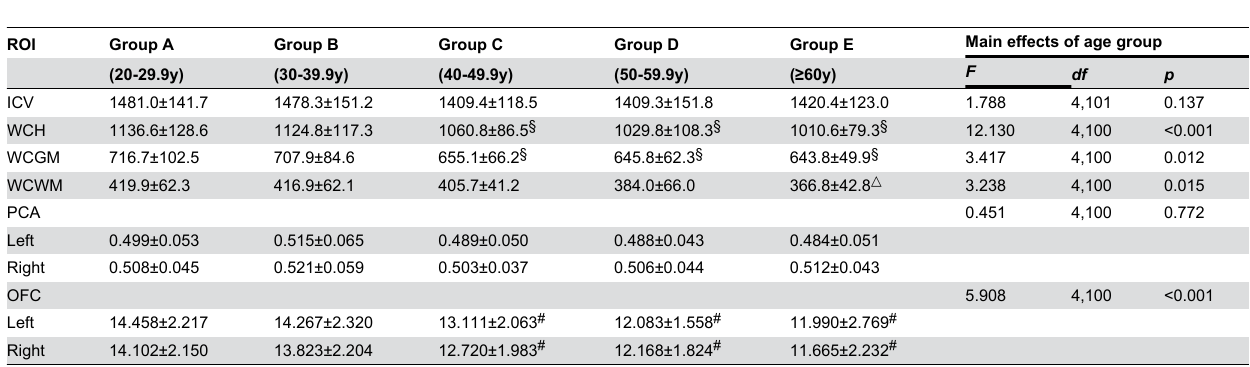
Table 1. Volumes of the intracranial cavity, cerebral hemisphere, cerebral gray and white matter, piriform and cortical amygdala (PCA) and orbitofrontal cortex (OFC) in each age